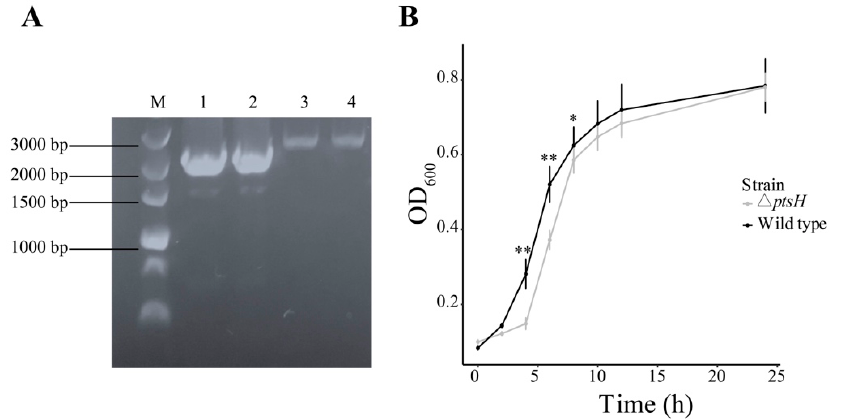
Figure 1. Identification of ptsH deletion mutant using PCR ( A ). M: DNA Ladder 5000; Lane 1, 2: Δ ptsH mutant; Lane 3, 4: WT strain. Growth curve of the WT strain and Δ ptsH mutant ( B ). Each value represents the average of three independent measurements. The bars represent the standard deviation ( n = 3). ** p < 0.01, * p < 0.05 compared to the WT strain.